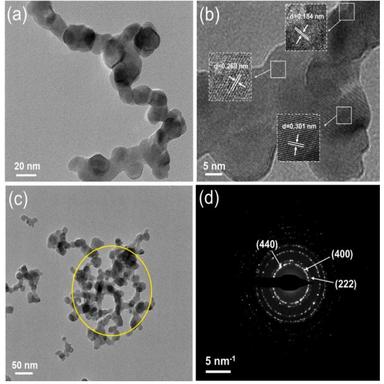
TEM analysis of RZ-850: (a, c) TEM images, (b) HR-TEM image, (d) SAED pattern.